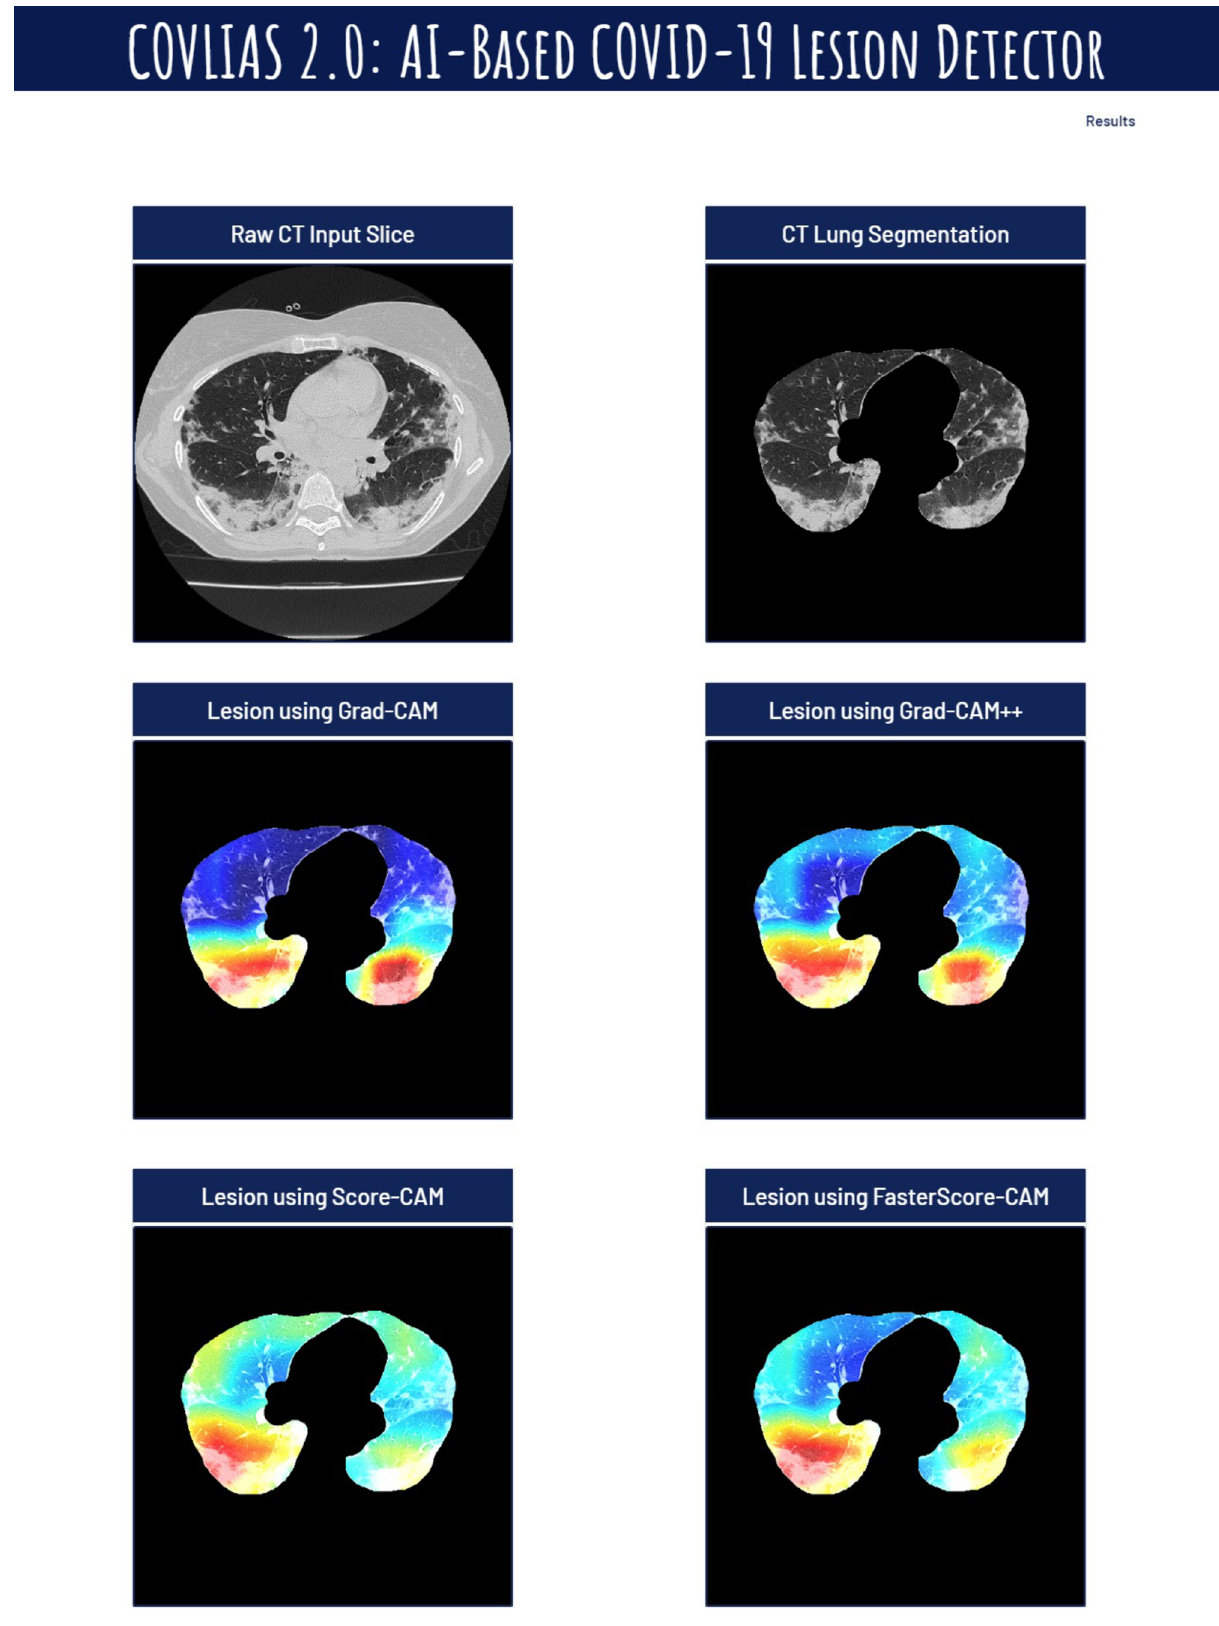
Figure 20. COVLIAS 2.0 cloud-based display of the lesion images using four CAM models.